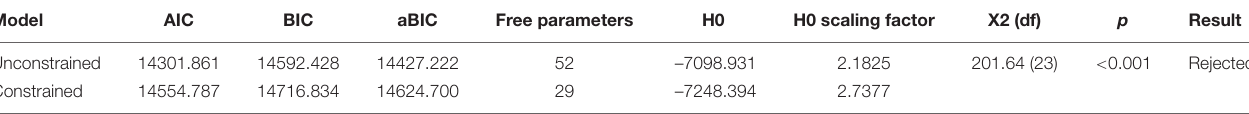
TABLE 3 | Measurement invariance model comparison.